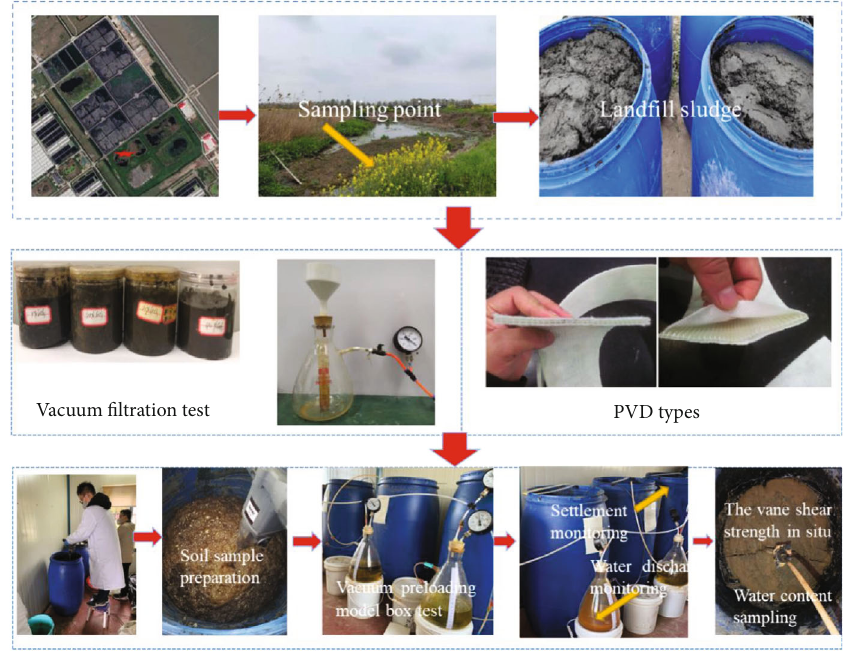
Figure 1: Flow diagram of this study. Table 1: Basic geotechnical properties of